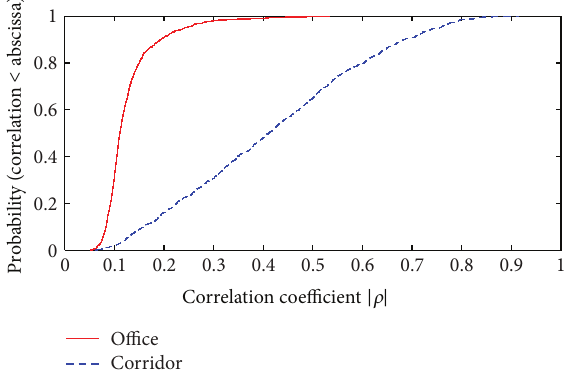
Figure 6: CDF of Tx spatial correlation coefficients for DAS in office and corridor